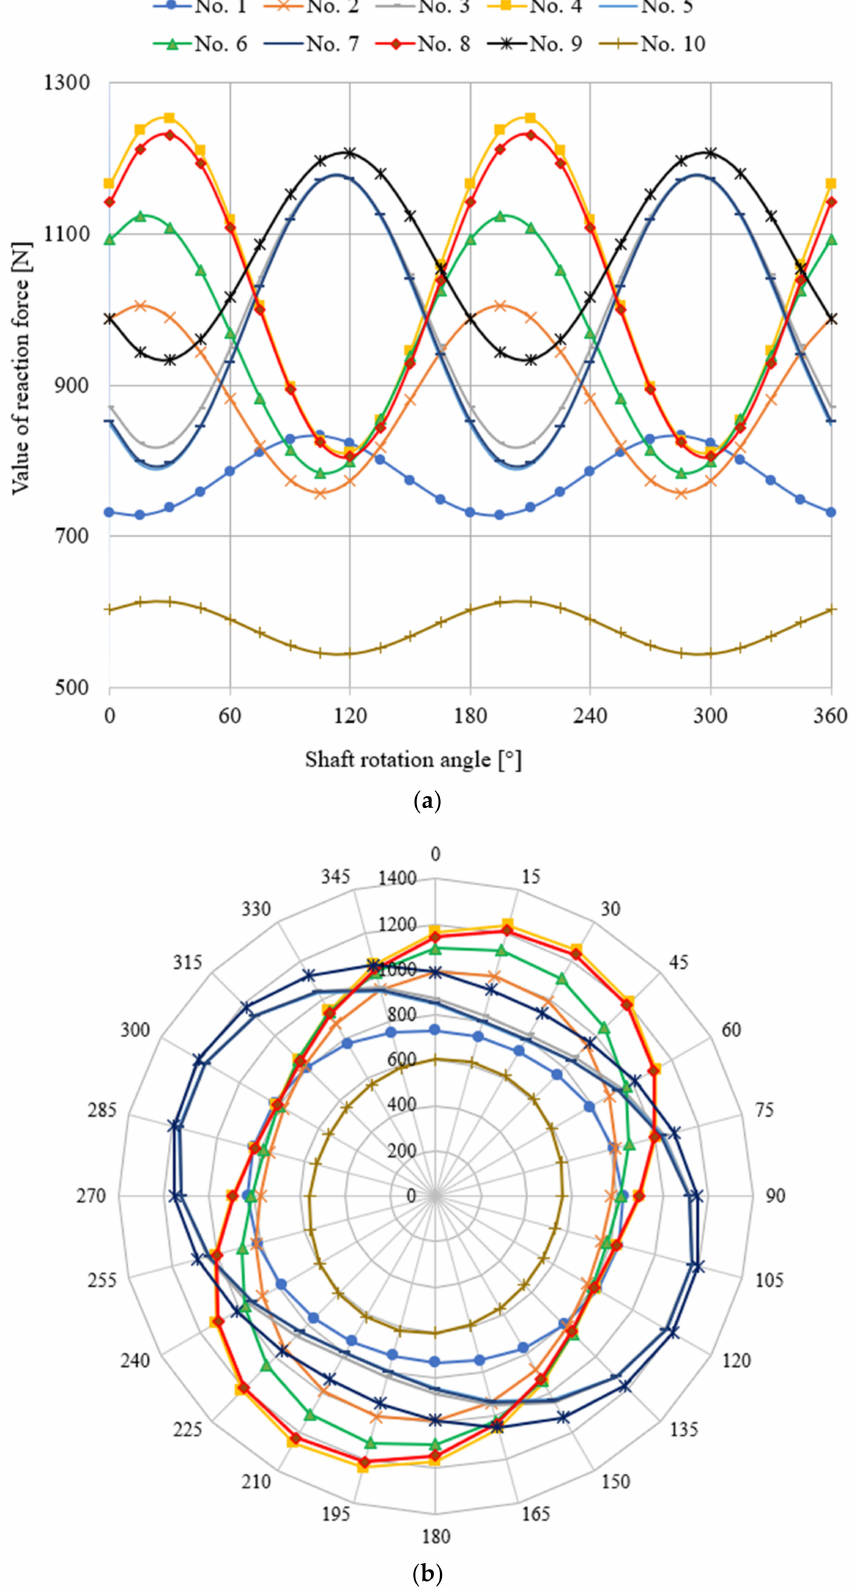
Figure 3. Distribution of the reaction forces guaranteeing zero value of deformations on the main pins of the crankshaft of a Buckau Wolf R8DV-136 motor. Diagrams of the coordinate systems: ( a ) Cartesian and ( b )